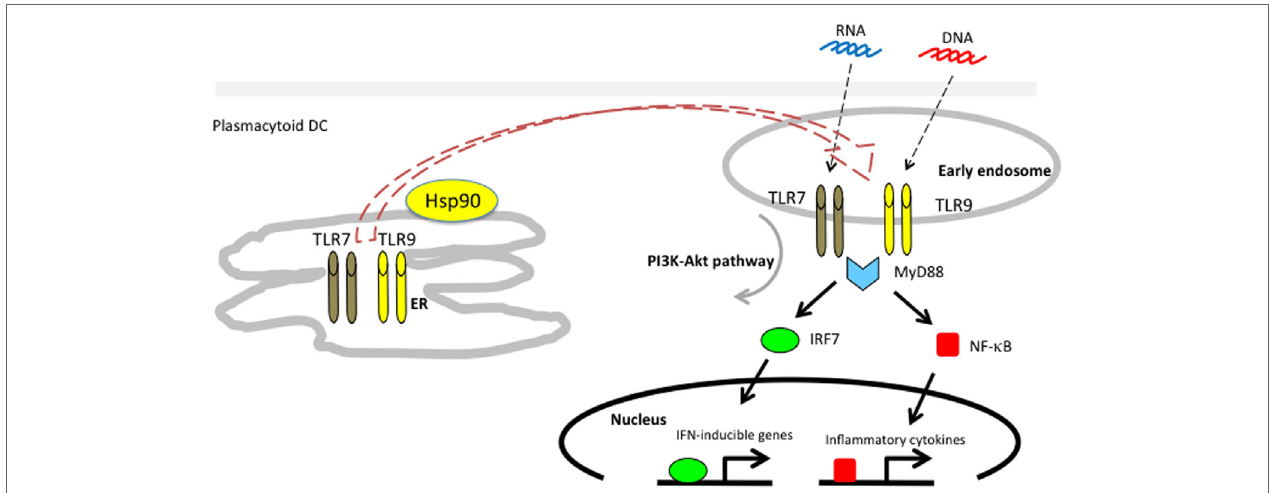
FiGURe 3 | Hsp90 associates with toll-like receptors 7/9 and mediates self-nucleic acid recognition in plasmacytoid DCs . Hsp90 has a spatial interaction with TLR7/9 and chaperones them from the ER to the early static